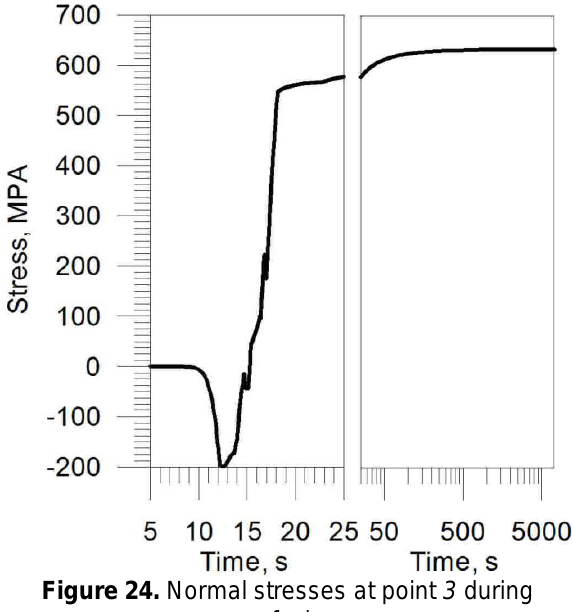
Figure 23. Normal stresses at point 2 during surfacing